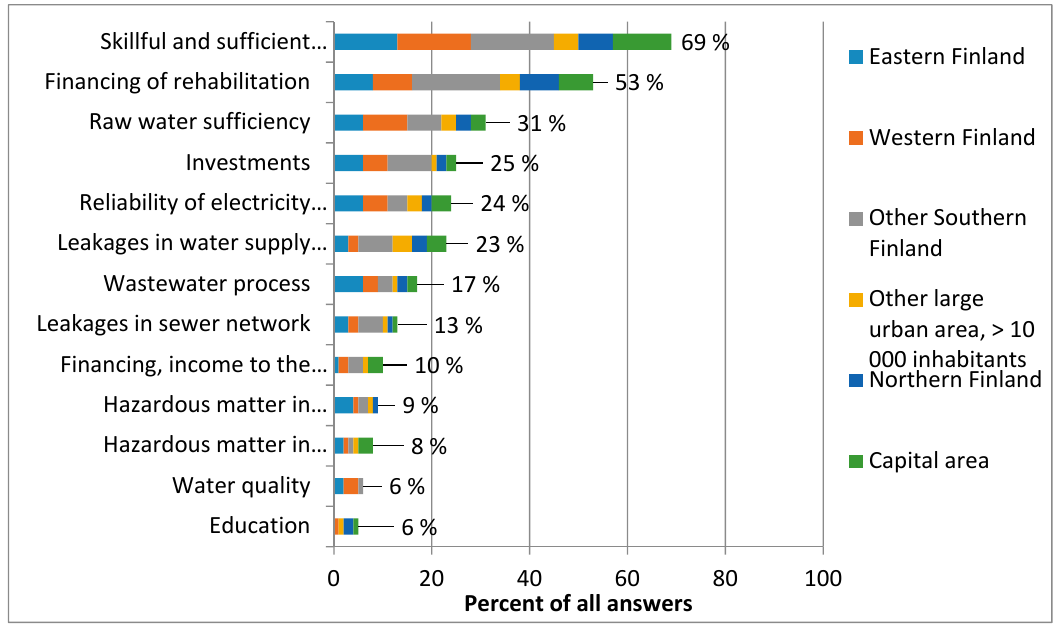
ffi cient water services, illustrated by regions (in % of all Figure 4. Topics for ensuring sufficient water services, illustrated by regions (in % of all answers). Figure 4. Topics for ensuring su